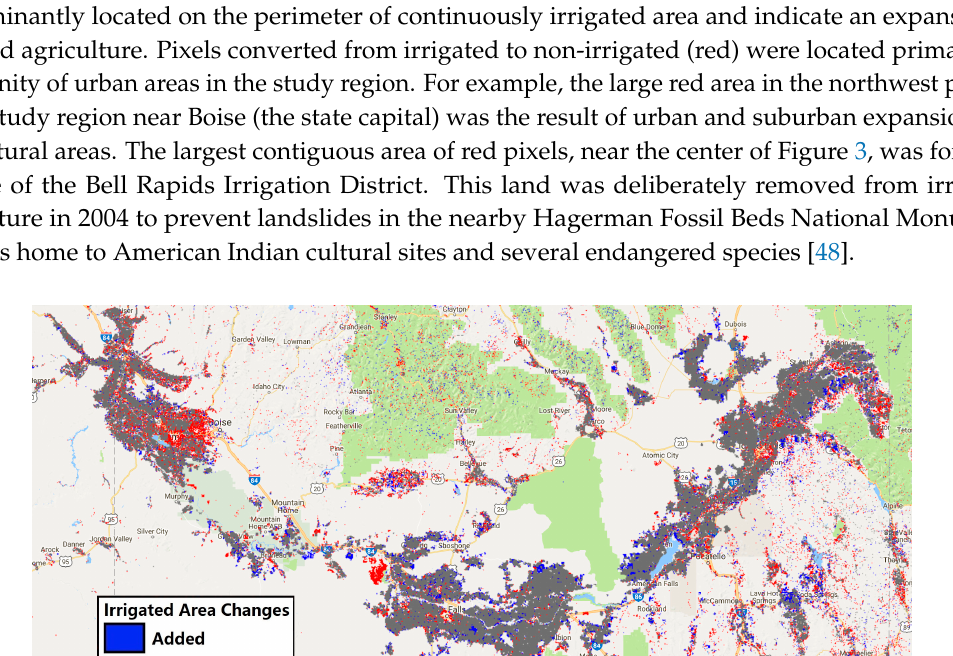
Figure 4. Matrix of scatterplots (off-diagonal, upper right) and R 2 (off-diagonal, lower left) for outcome variables (NDMI threshold; mean NDMI on all pixels, irrigated pixels, and non-irrigated pixels; and irrigated land area), precipitation variables (single-site precipitation measured in Jerome vs. watershed precipitation), and year in the time series. For example, column 6, row 1 illustrates the scatterplot of NDMI threshold values against precipitation in Jerome and column 1, row 6 contains the corresponding R 2 value of 0.398. Shading of R 2 values is darkest for the largest values and lightest for the values closest to zero. Irrigated area is in km 2 ; precipitation is in mm.